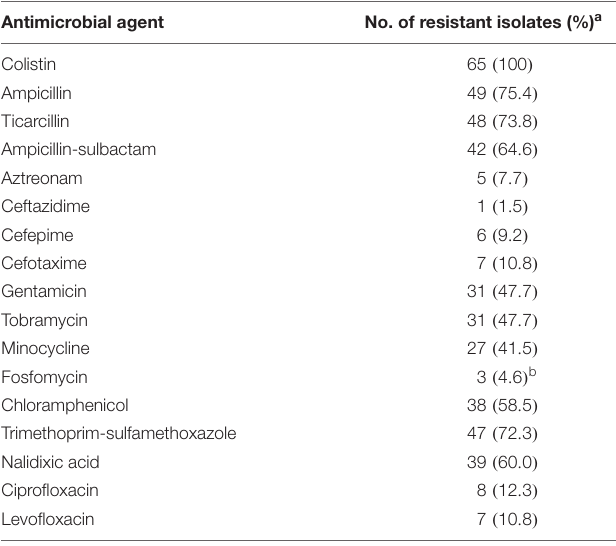
TABLE 4 | Prevalence of antimicrobial resistances among the 65 mcr-1 diarrheagenic E. coli . Antimicrobial agent No. of resistant isolates (%)